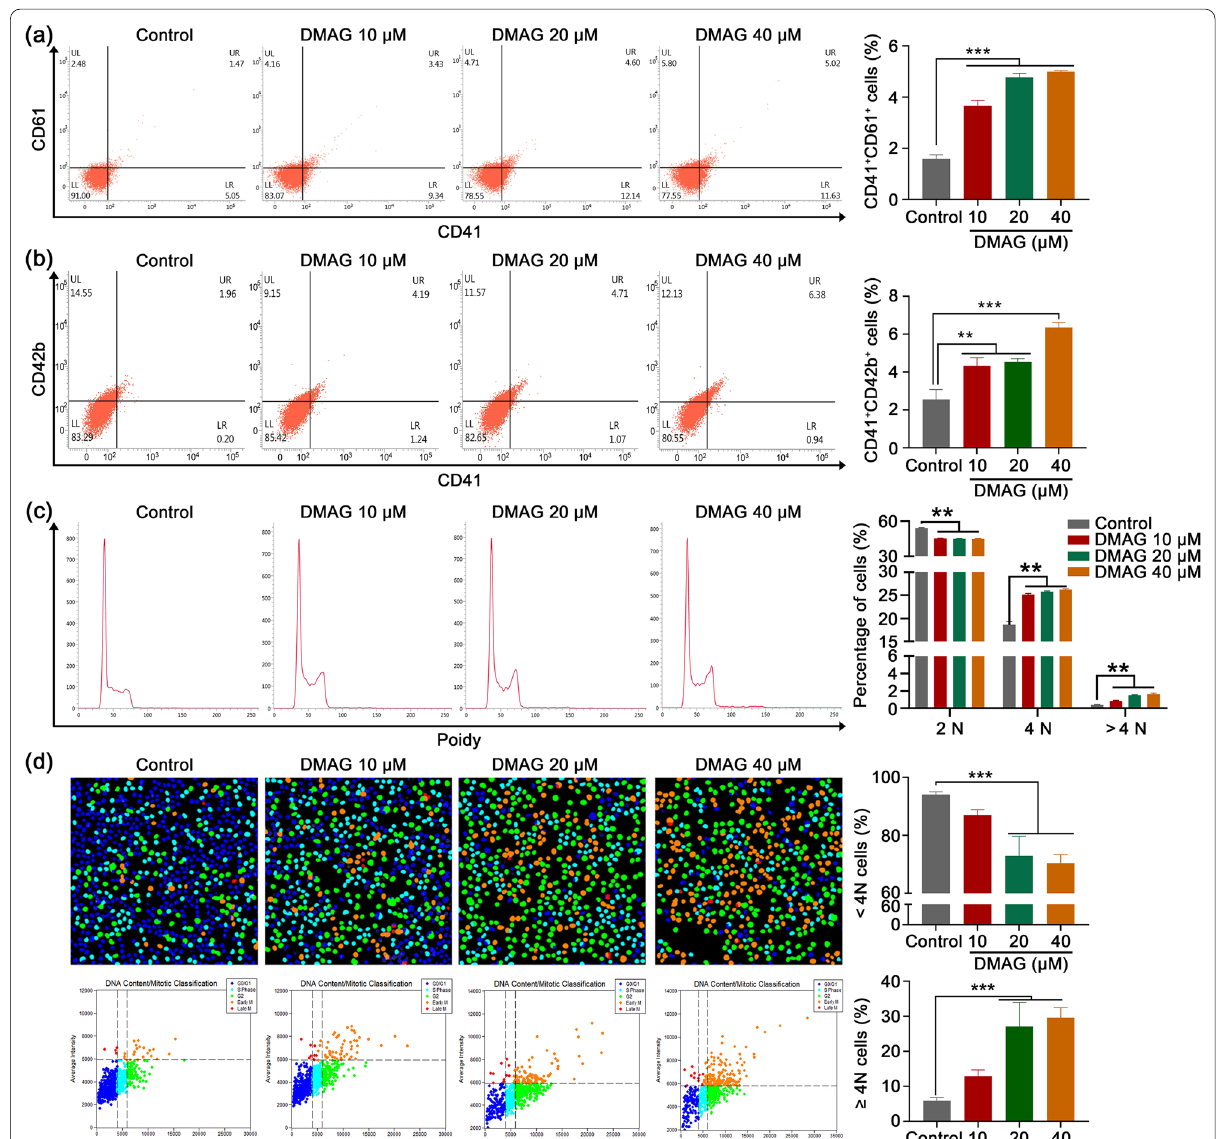
Fig. 2 DMAG induces the differentiation of HEL cells. a The expression of CD41 and CD61 was detected by flow cytometry after the HEL cells were treated with DMAG (10, 20 and 40 μM) for 6 days. The histogram shows the percentage of CD41 + CD61 + cells in each group. The data represent the mean SD of three independent experiments; *** p < 0.001, compared to the control group. b The expression of CD41 and CD42b was measured by ± flow cytometry after the HEL cells were treated with DMAG (10, 20 and 40 μM) for 6 days. The histogram shows the percentage of CD41 + CD42b + cells in each group. The data represent the mean SD of three independent experiments; ** p < 0.01, *** p < 0.001, compared to the control group. c ± Flow cytometry analysis of DNA ploidy after the cells treated with DMAG (10, 20 and 40 μM) for 6 days. The histogram shows the percentage of DNA ploidy in each group. The data represent the mean SD of three independent experiments; ** p < 0.01, *** p < 0.001, compared to the control group. ± d HCS analysis of DNA ploidy after the cells treated with or without DMAG (10, 20 and 40 μM) for 6 days. Cells were marked with blue, turquoise, green, orange and red. The different colors represent different phases of the cell cycle. Blues indicate G0/G1 (2 N) cells. Turquoises indicate S (2 N) cells. Greens represent G2 ( 4 N) cell. Oranges represent early M ( 4 N) cells. Reds represent late M (2 N) cells. The histogram shows the percentage ≥ ≥ of DNA ploidy in each group. The data represent the mean SD of three independent experiments; *** p < 0.001, compared to the control ±